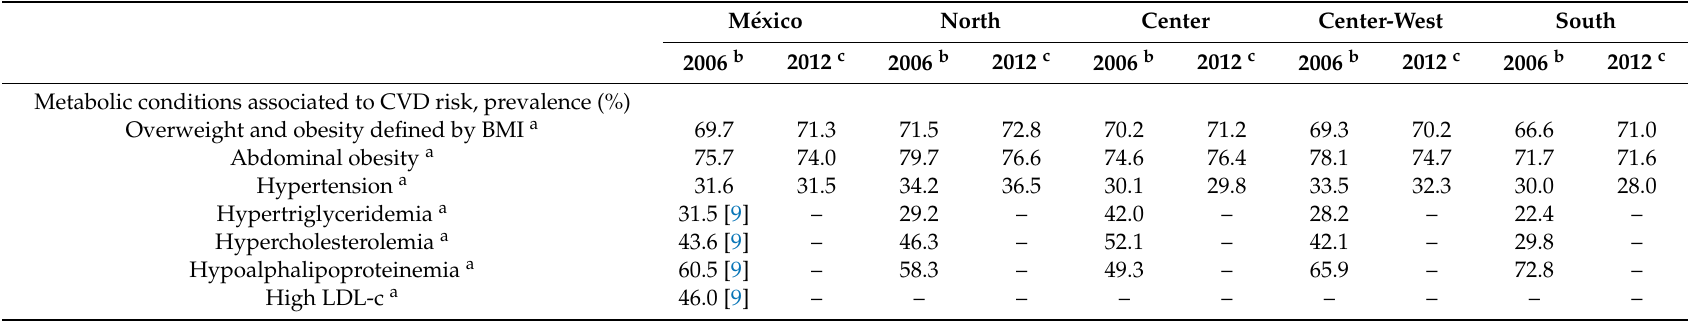
Table 1. Prevalence of cardiovascular diseases (CVD) risk factors according to Mexican National Surveys, 2006 and 2012. M é xico